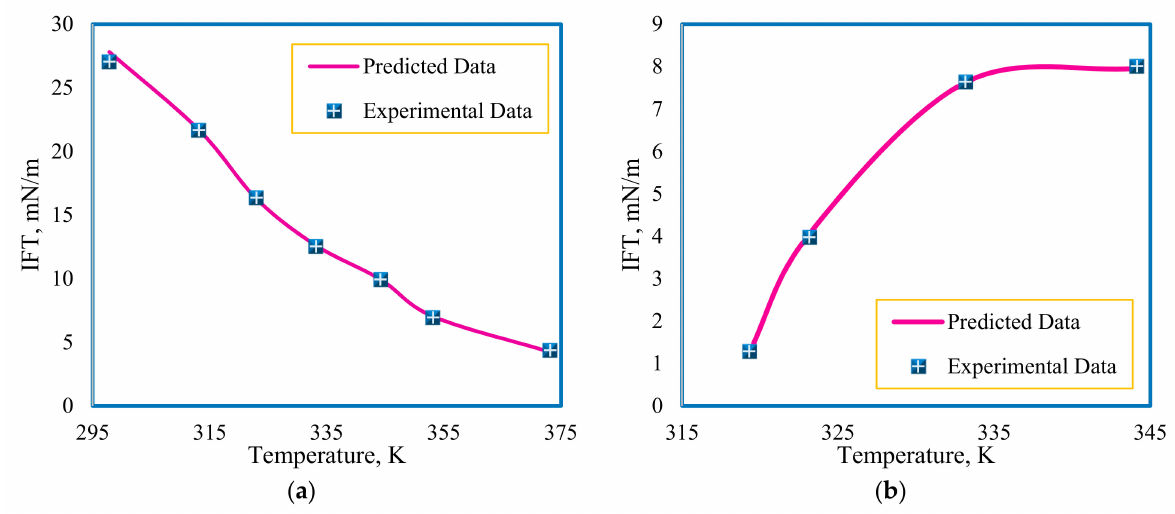
Figure 7. Influence of temperature on IFT at: ( a ) low and ( b ) high pressure ranges, according to experimental values and RBF-ICA